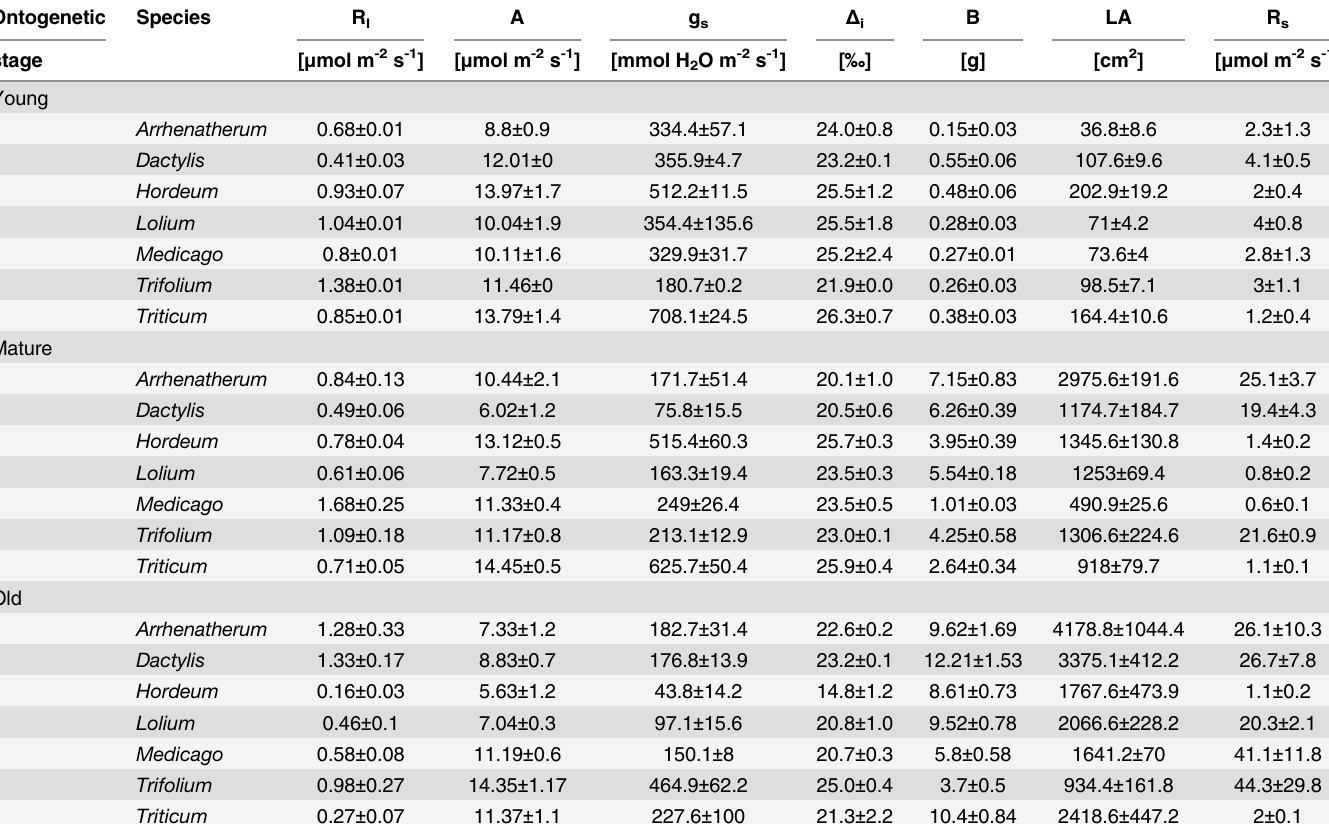
Table 1. Leaf respiration rate (R l ), net assimilation rate (A), leaf stomatal conductance to H 2 O (g s ), instantaneous predicted photosynthetic dis- crimination ( Δ i ), aboveground biomass at the whole pot level (B), leaf area at the whole pot level (LA) and soil respiration rate (R s ) for different plant species at three ontogenetic stages (young foliage, maximum growth rate and beginning of senescence, indicated by young, mature and old, respectively). A, g s and Δ i (recalculated with b = 27 ‰ ) values are from Salmon et al. (2011). Values are mean ± 1SE (n =